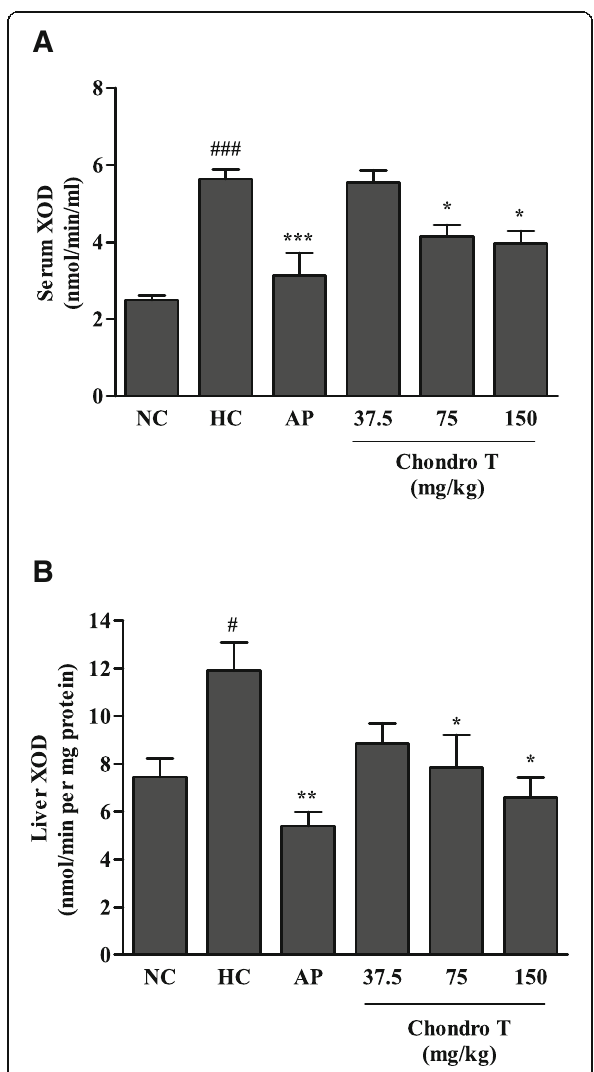
Fig. 2 Effects of ChondroT on ( a ) serum and ( b ) liver xanthine oxidase (XOD) activities of potassium oxonate (PO)-induced hyperuricemic mice NC, normal control; HC, hyperuricemic control with potassium oxonate (300mg/kg); AP, allopurinol (5 mg/kg). Values are expressed as the mean ± standard error (S.E., n = 5). # P < 0.05 and ### P < 0.001 compared with NC group; * P < 0.05, ** P < 0.01, and *** P < 0.001 compared with HC